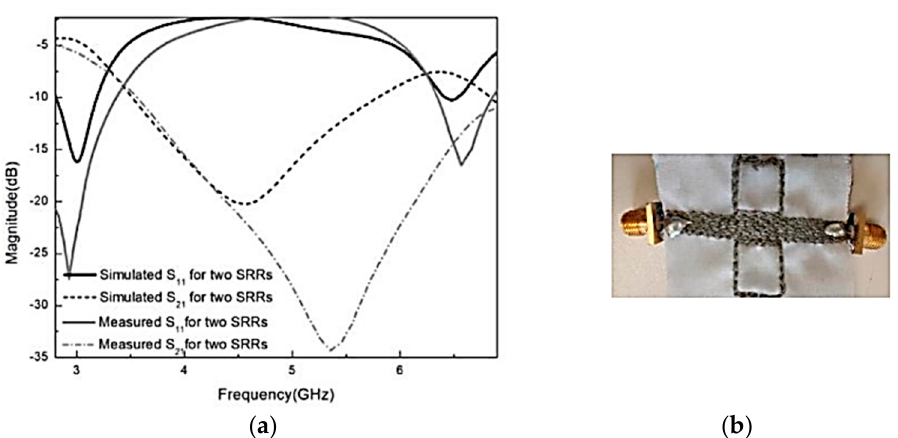
Figure 5. Reflection coefficient responses of the transmission line loaded with two SRRs ( a ) and photograph of the embroidered sample ( b ).